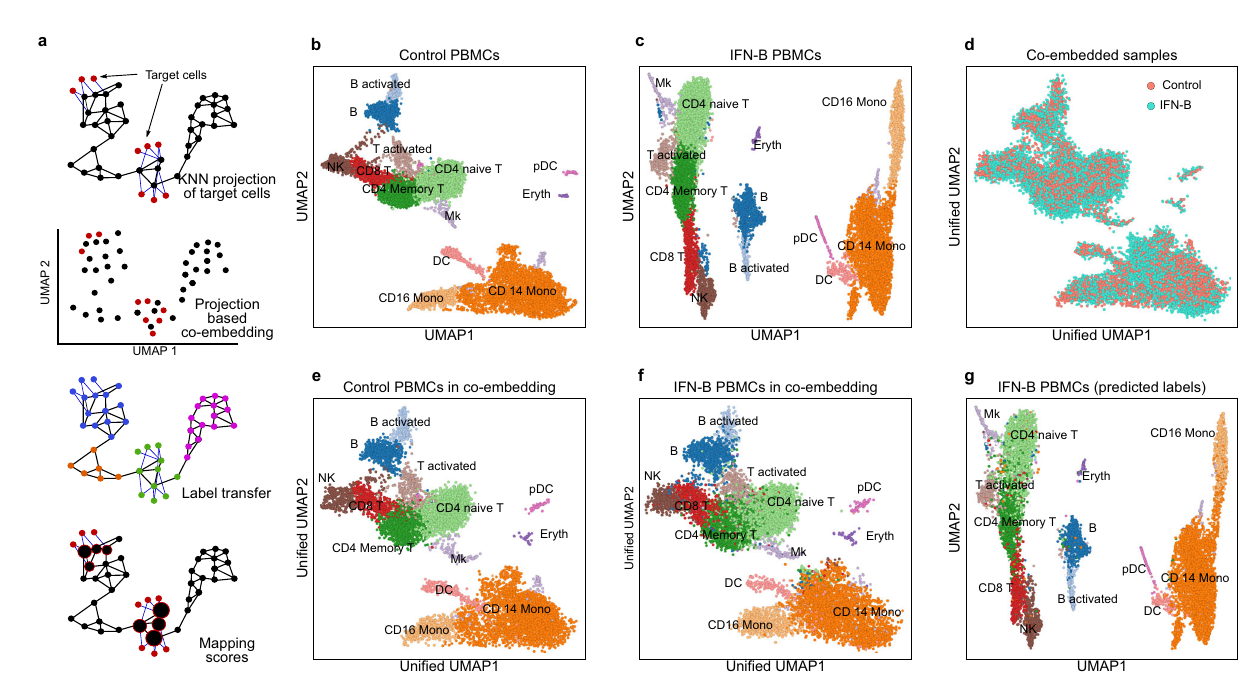
Fig. 4 | Comparison of Scarf, GeoSketch and random sampling on small-scale datasets. a Percentage of subsampled cells from 10K PBMC dataset and b differentiating pancreatic cells that have non-zero graph degrees. Max sampling rate for TopACeDo set at 1% and the same number of cells as subsampled with TopACeDo was used for random sampling and GeoSketch. Bars represent mean anderrorbarsindicatestandarddeviationobtainedusing100runsofsubsampling.